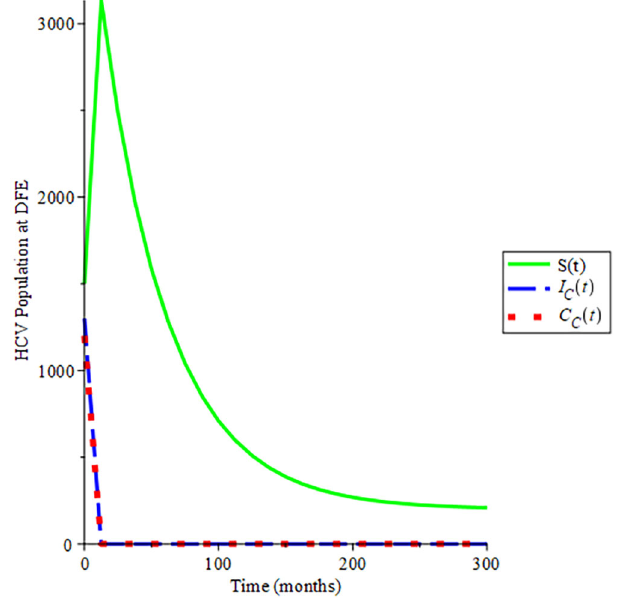
Figure 4. Proportion of different population of HCV at DFE when R 0 < 1.